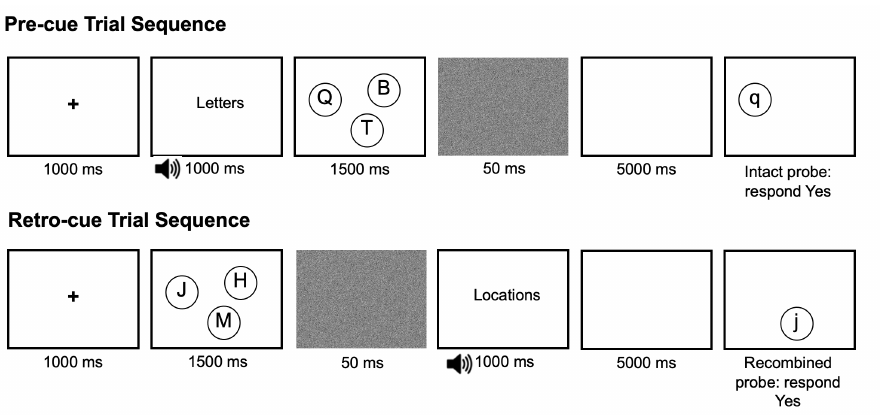
Figure 1. Trial events with timings for pre- and retro-cued trials. Negative probes, in which either the relevant feature or both features were new, were also included. Elements are not shown to scale. Reminder of feature test at probe screen appeared at the top of the screen, above the ranges of possible